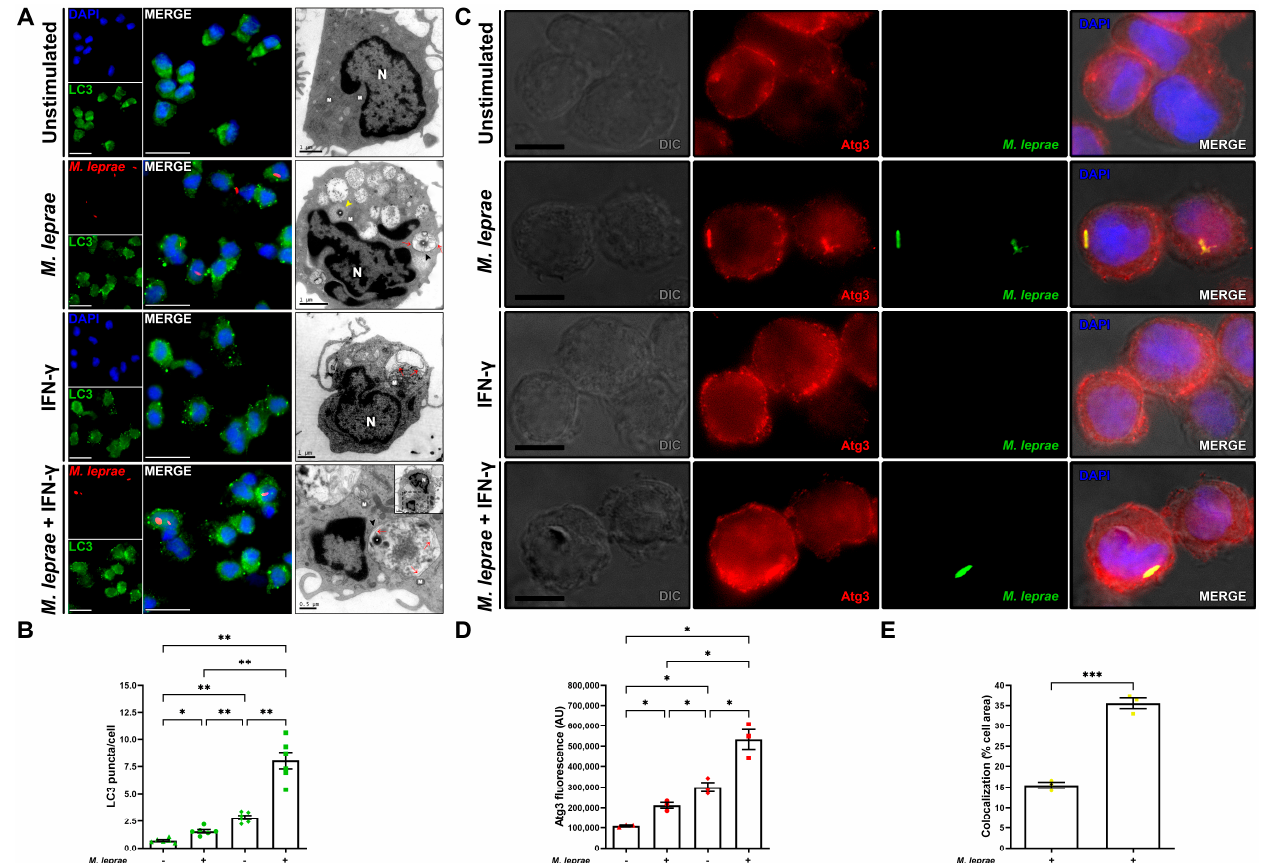
Figure 1. IFN- γ positively regulated autophagy in monocytes stimulated with M. leprae . ( A ) Human monocytes were stimulated with M. leprae (MOI 10:1) for 30 min, then treated with 10 ng/mL of IFN- γ for 18 h and processed for analysis by immunofluorescence or transmission electron microscopy. LC3 (green), M. leprae stained with PKH26 (red), and the nucleus stained with DAPI (blue). Red arrows indicate double-membrane (autophagosomes) visible sites; black arrowheads indicate M. leprae -containing autophagosomes; yellow arrowheads indicate M. leprae -containing phagosomes; asterisks indicate M. leprae ; M indicates mitochondria; N indicates nucleus. The images are representative of six (fluorescence) or three (TEM) experiments. Scale bar: 20 µ m. ( B ) Quantification of LC3 puncta per cell in the same conditions mentioned above. Data are the mean ± S.E.M; * p < 0.05, ** p < 0.01 by the repeated measures one-way ANOVA with the Geisser–Greenhouse correction and Tukey’s multiple comparisons test. ( C ) Human THP-1 macrophages were stimulated with M. leprae -PKH26 (green) for 30 min (MOI 10:1) and treated with 10 ng/mL of IFN- γ for 18 h. Atg3 expression was evaluated by immunofluorescence microscopy using anti-Atg3 antibody (red), with the nucleus stained with DAPI (blue). The images are representative of three experiments. Scale bar: 10 µ m. Differential interference contrast (DIC). ( D ) Quantification of Atg3 fluorescence in the same conditions mentioned above. ( E ) Quantification of the percentage of M. leprae organisms colocalized with Atg3. Data are the mean ± S.E.M; * p < 0.05, *** p < 0.001 by the repeated measures one-way ANOVA with the Geisser–Greenhouse correction and Tukey’s multiple comparisons test ( D ) or two-tailed paired t -test ( E